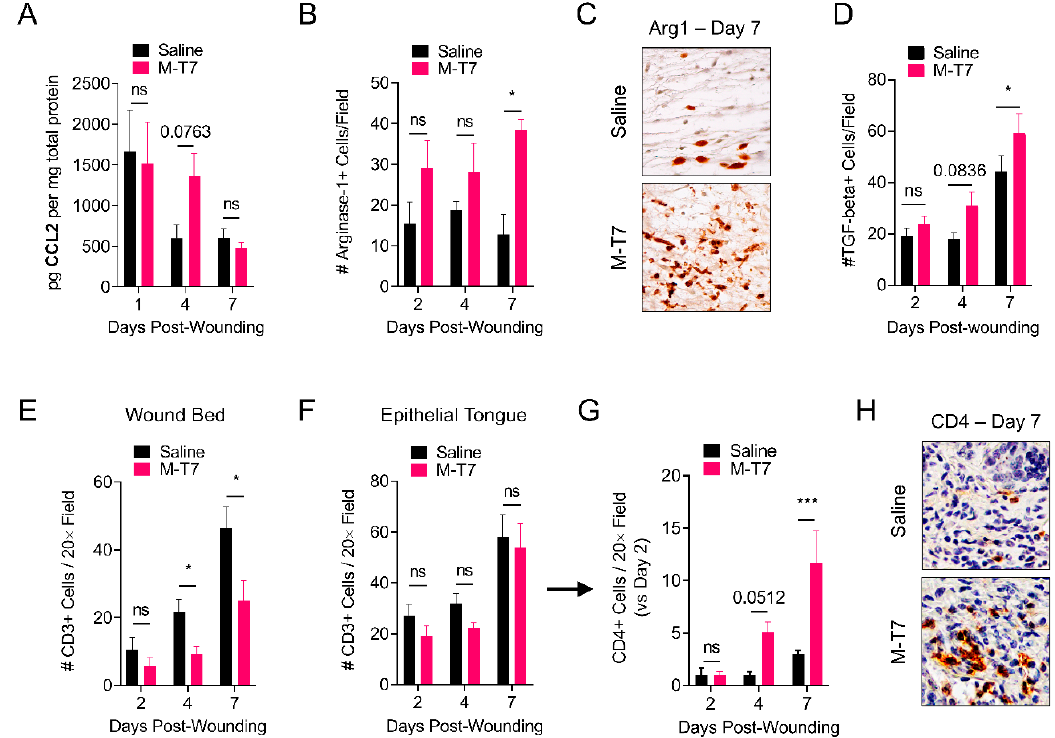
Figure 4. M-T7 modulates the immune response in the healing wound. ( A ) ELISA quantification of CCL2 in wounds treated with saline or M-T7 at days 1, 4 and 7 post-wounding, normalized to total protein. ( B ) Quantification of Arginase-1 + cells per 20 × field of wounds treated with saline or M-T7 at days 2, 4 and 7 post-wounding. ( C ) Representative Arginase-1 IHC fields at day 7. ( D ) Quantification of TGF-beta + cells per 20 × field on days 2, 4 and 7 post-wounding. ( E , F ) Quantification of CD3 + cells per 20 × field of wounds treated with saline or M-T7 at days 2, 4 and 7 post-wounding, specifically in the ( E ) wound bed or ( F ) epithelial tongue. ( G ) Quantification of CD4 + cells per 20 × field of wounds treated with saline or M-T7 at days 2, 4 and 7 post-wounding normalized to the numbers on day 2. ( H ) Representative CD4 IHC fields in the epithelial tongue at day 7. Full 20 × field is given in Figure S2. All bars are mean and standard error. Statistics are calculated by two-way ANOVA with Fisher’s LSD post-hoc analysis. N = 3–4 in each group and time point.